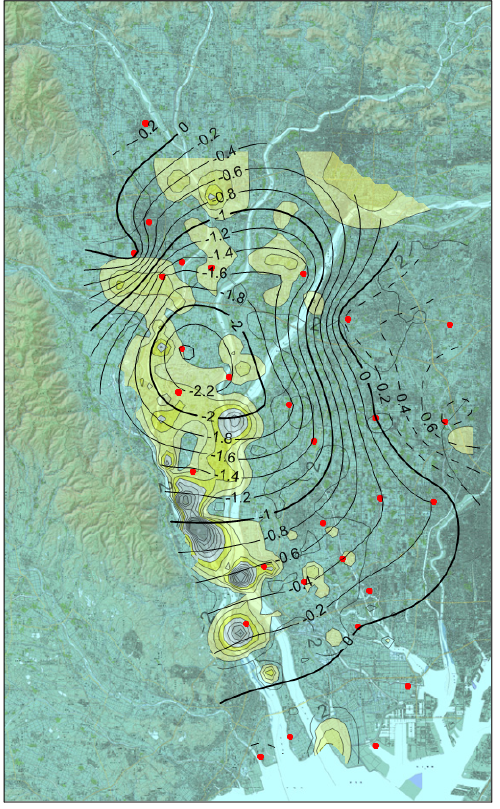
Figure 5. Decrease of piezometric head of groundwater in summer and land subsidence area (2007).